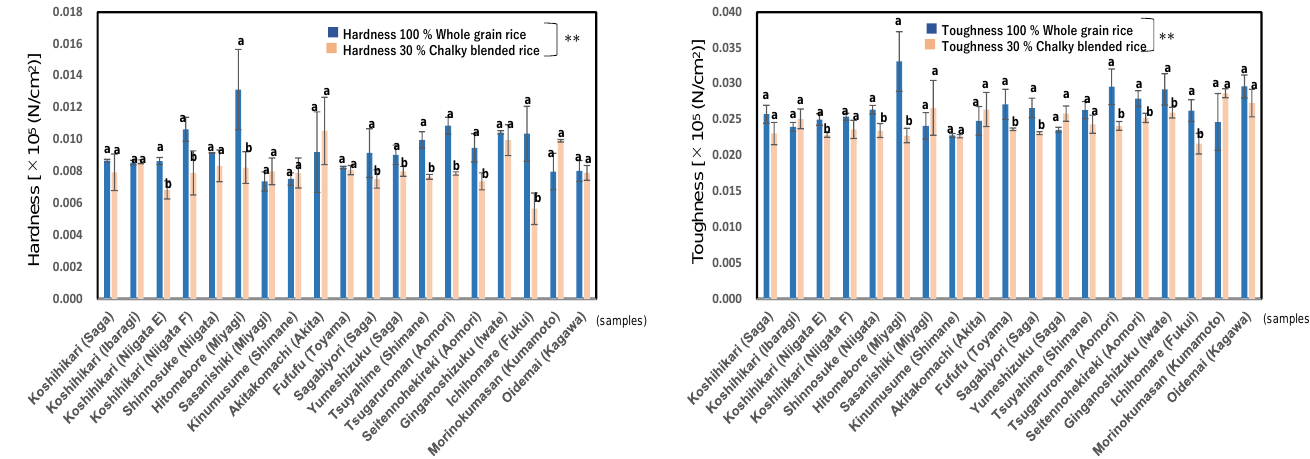
Figure 5. Physical properties of boiled rice of 100% whole rice grains and 30% chalky rice blended grains in 19 kinds of Japonica rice in 2020. Different letters (a, b) mean that whole and 30% chalky grains in each same rice samples are significantly different. ** Correlation is significant at 1% by the method of Tukey’s multiple comparison .